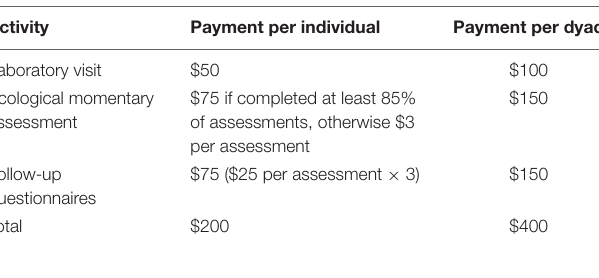
TABLE 5 | Incentives as a function of study